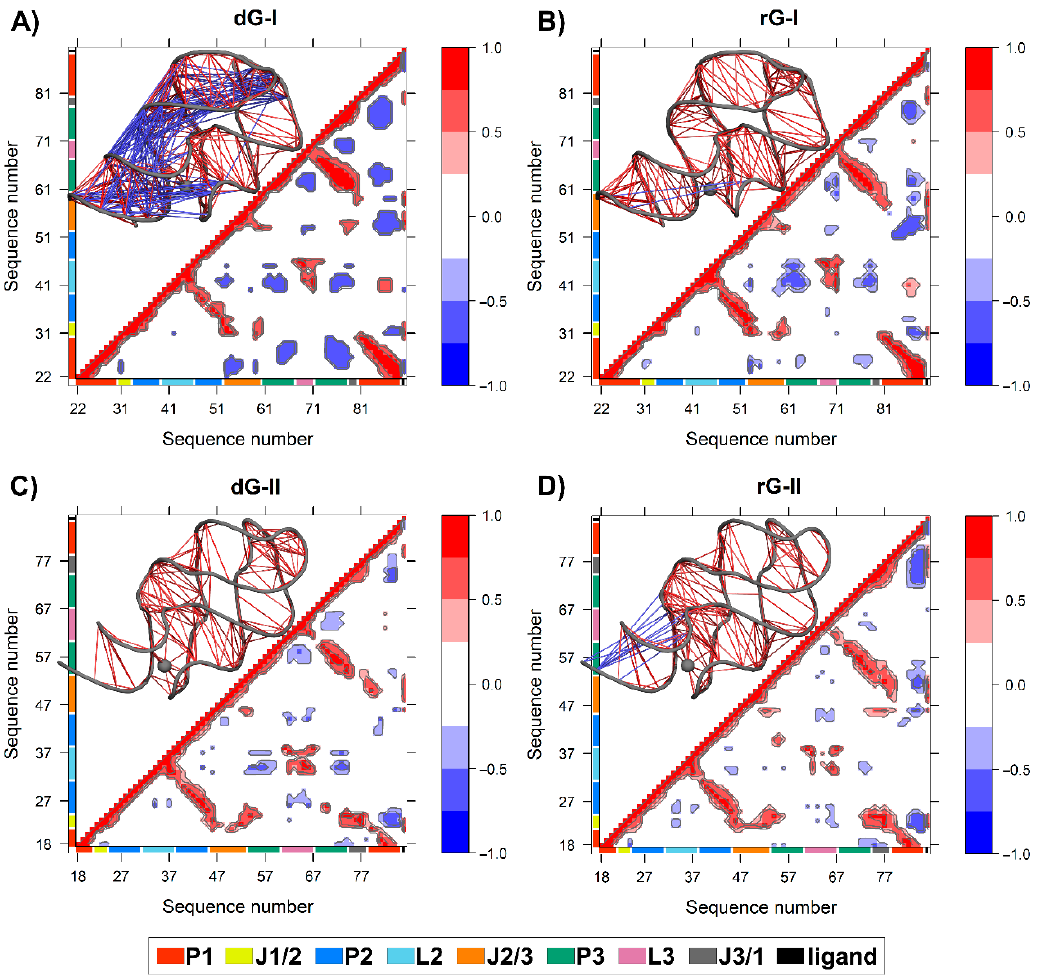
Figure 7. The dynamic cross-correlation matrices (DCCM) of 2′-dG-I ( A , B ) and 2′-dG-II ( C , D ) riboswitches classes bound to dG ( A , C ) and rG ( B , D ). Next to each matrix, the corresponding 3D structures with lines connecting pairs of correlated residues are shown. Only the pairs presenting (|Cij|) > 0.6. are represented for clarity’s sake. The aptamer substructures are depicted at the margin of the plots and colored according to the figure caption.